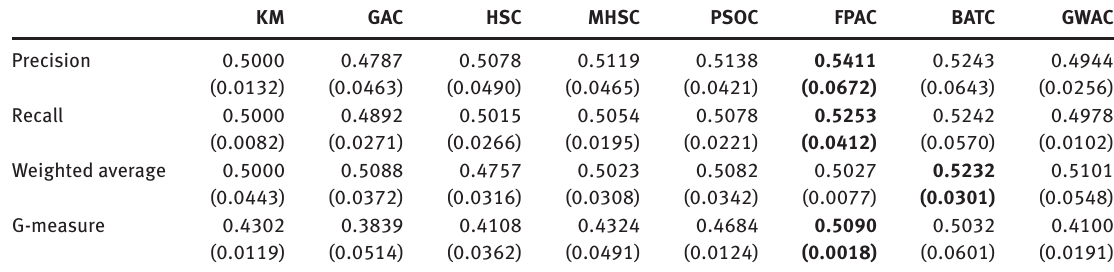
Table 9: Mean (SD) of Cluster Quality Matrices for Bupa Data